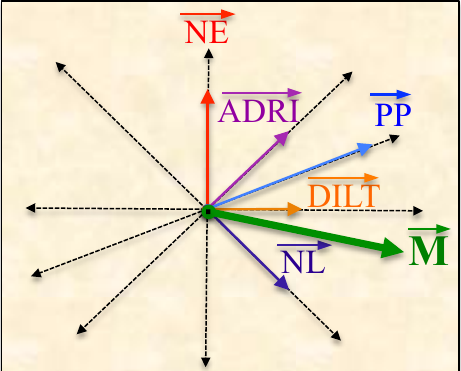
Figure 30. FVS of attributes of the object mayor, French title